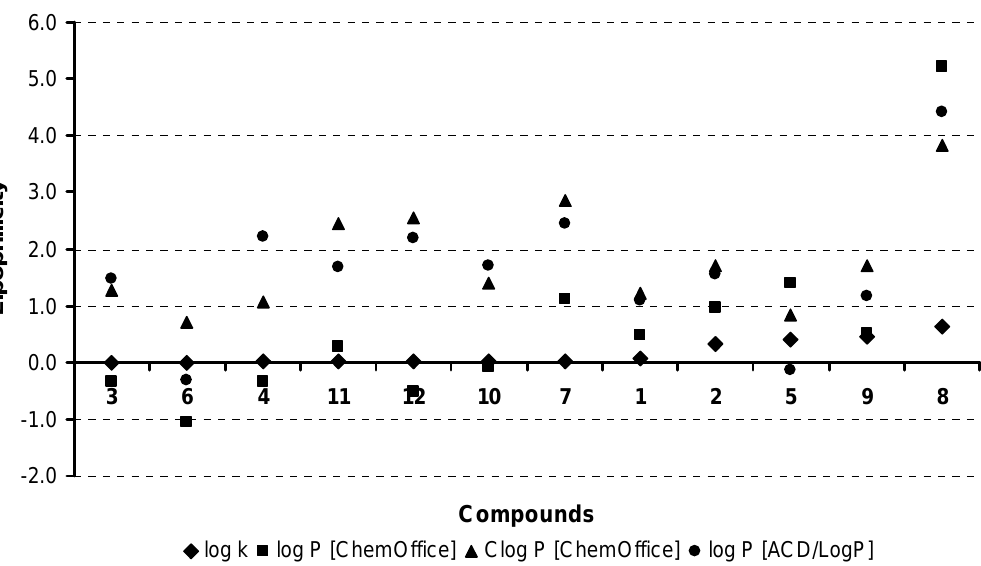
Figure 1. Comparison of the computed log P /Clog P values using the two programs with the calculated log k values. The discussed compounds 1-12 are ordered according to the log k values